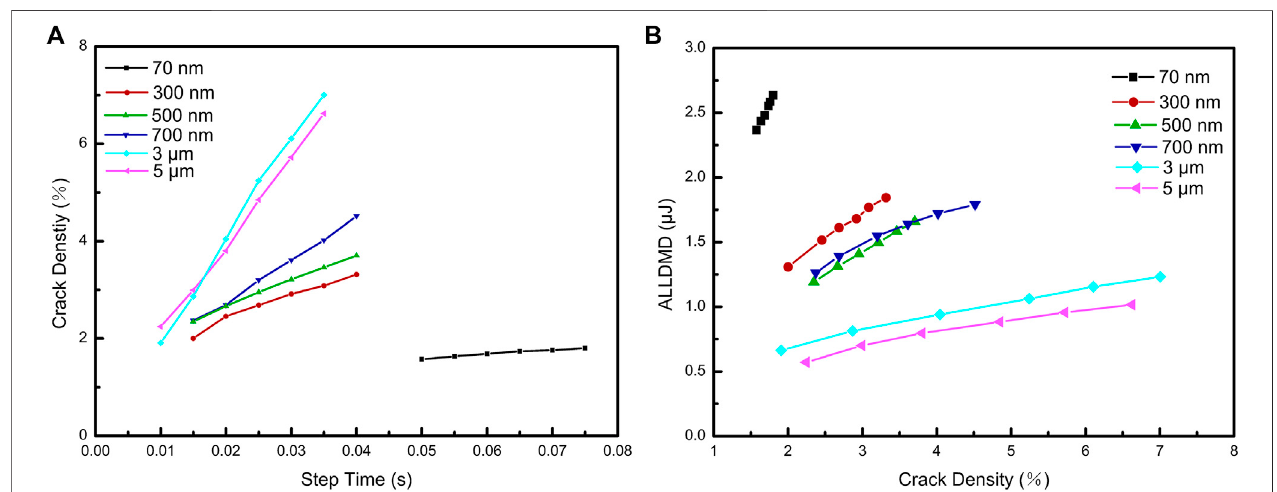
FIGURE 6 | (A) Curves of step time versus crack density with different grain sizes; (B) curves of crack density versus the ALLDMD with different grain sizes.